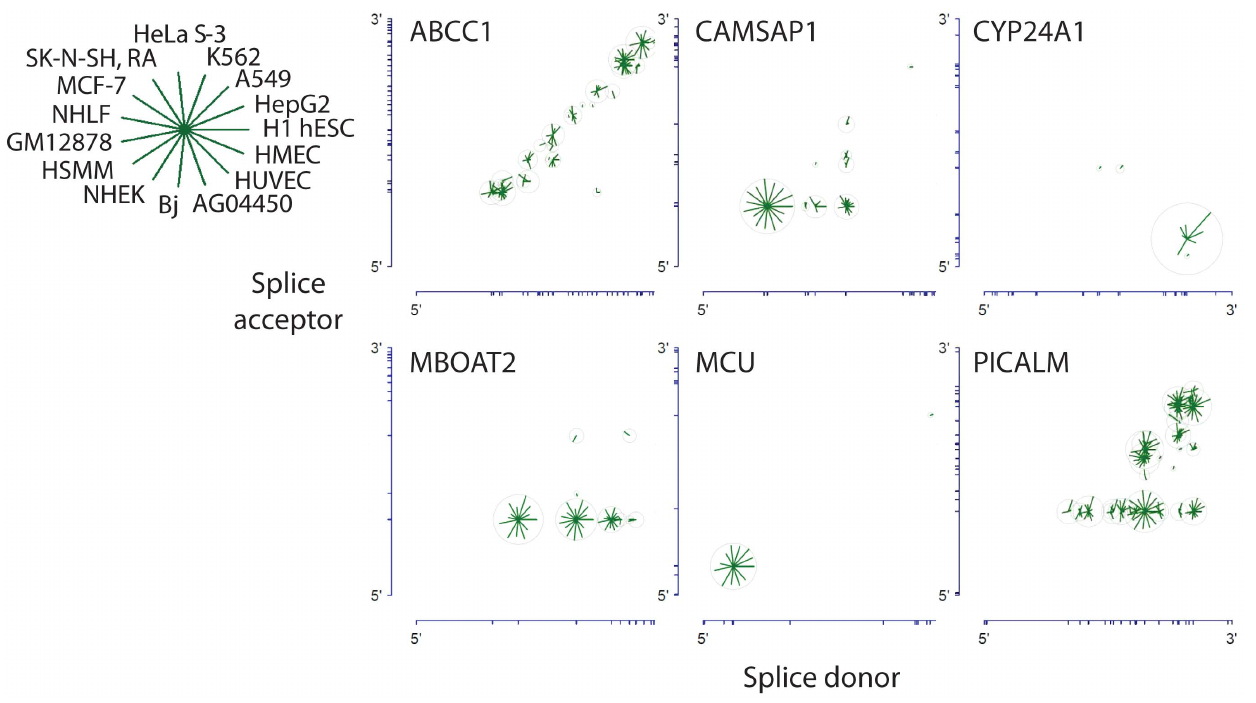
Figure 7. Circular isoform expression patterns involves a variety of splicing patterns including proximal pairing and combinatorial expression. Gene structures are represented along the axes with tick marks at splice site boundaries. Each circle is centered at the genomic coordinates corresponding to the donor and acceptor splice sites of the detected circular isoform. The length of the line segment is proportional to the log of the expression level of the circular isoform; the ring represents the maximum expression of the circular isoform across cell types. CYP24A1 and MCU exhibit striking expression preference for a single circular isoform. MBOAT2 exhibits a strong preference for a single splice acceptor site paired with multiple donors. ABCC1 exhibits preference for proximal pairs of splice donors and acceptors; CAMSAP1 exhibits a strong preference for either a particular single acceptor and or a particular single donor, whereas PICALM is an example of a gene with high combinatorial use of splice